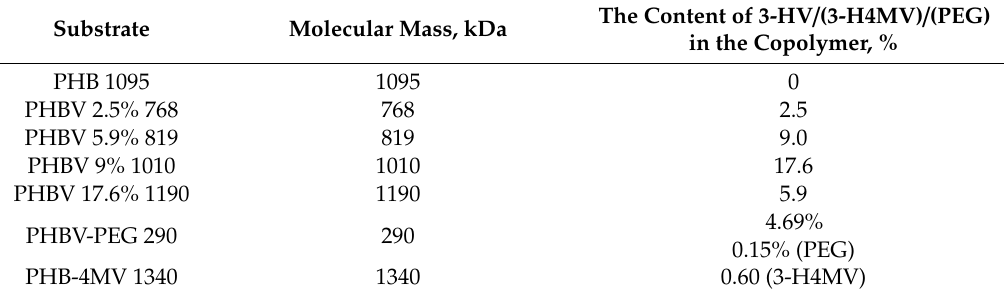
Table 1. The list of polymers used in the work. HV = hydroxyvalerate; PEG = polyethylene glycol; PHB = poly(3-hydroxybutyrate); PHBV = poly(3-hydroxybutyrate-co-3-hydroxyvalerate); MV = methylvalerate. The Content of 3-HV / (3-H4MV) / (PEG) Substrate Molecular Mass, kDa in the Copolymer,